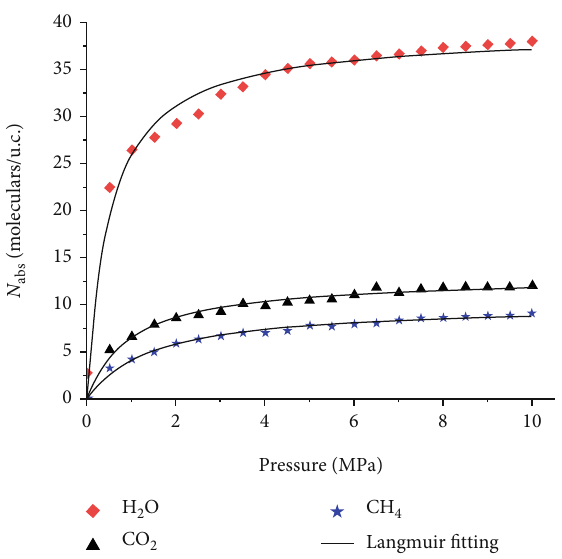
Figure 4: Adsorption isotherms of lignite on CH